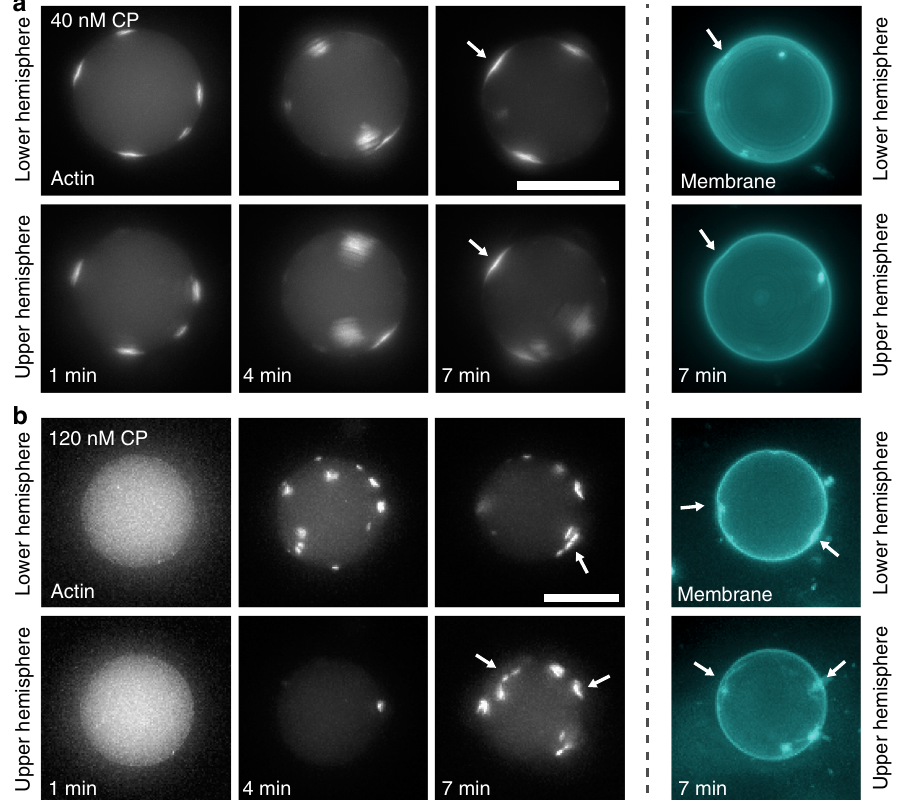
Fig. 3 Snapshots of the temporal evolution of actin domain formation controlled by CP concentration are shown. a , b Projections of epi fl uorescence z - stacks show the temporal evolution of actin domain formation at the membrane in the presence of 40 and 120 nM CP, respectively. a Domain formation of actin at the membrane was fast in the presence of 40 nM CP. Already one minute after production has been fi nished, domains were visible at the membrane. Domain growth continued over time and a bending of the membrane was observable after 7 min (arrows). b Domain formation at 120 nM CP was slowed down. One minute after production domains were not observable, after 4 min domains became visible and after seven minutes a concave shaping of the membrane was induced (arrows). Please note that during the acquisition the vesicles were freely rotating and thus the domains occur at different positions in the images. To avoid bleaching effects only very limited number of snapshots was taken. All scale bars are 20 µ